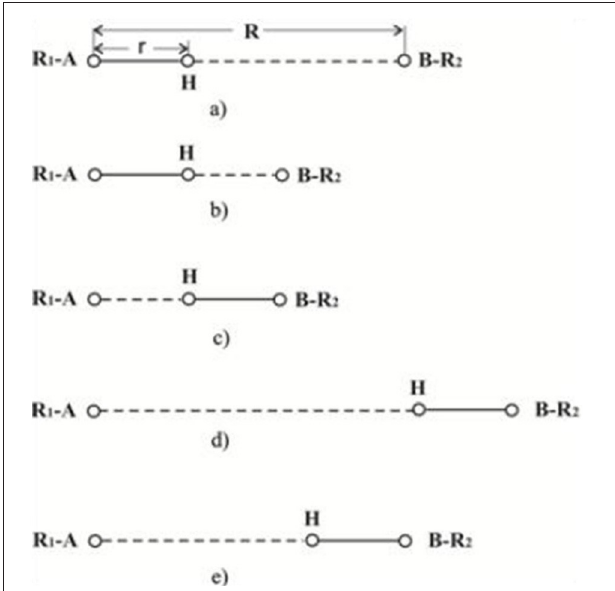
FIGURE 2 | Diagrammatic representation of hydrogen bonding between R1-A and B-R2.